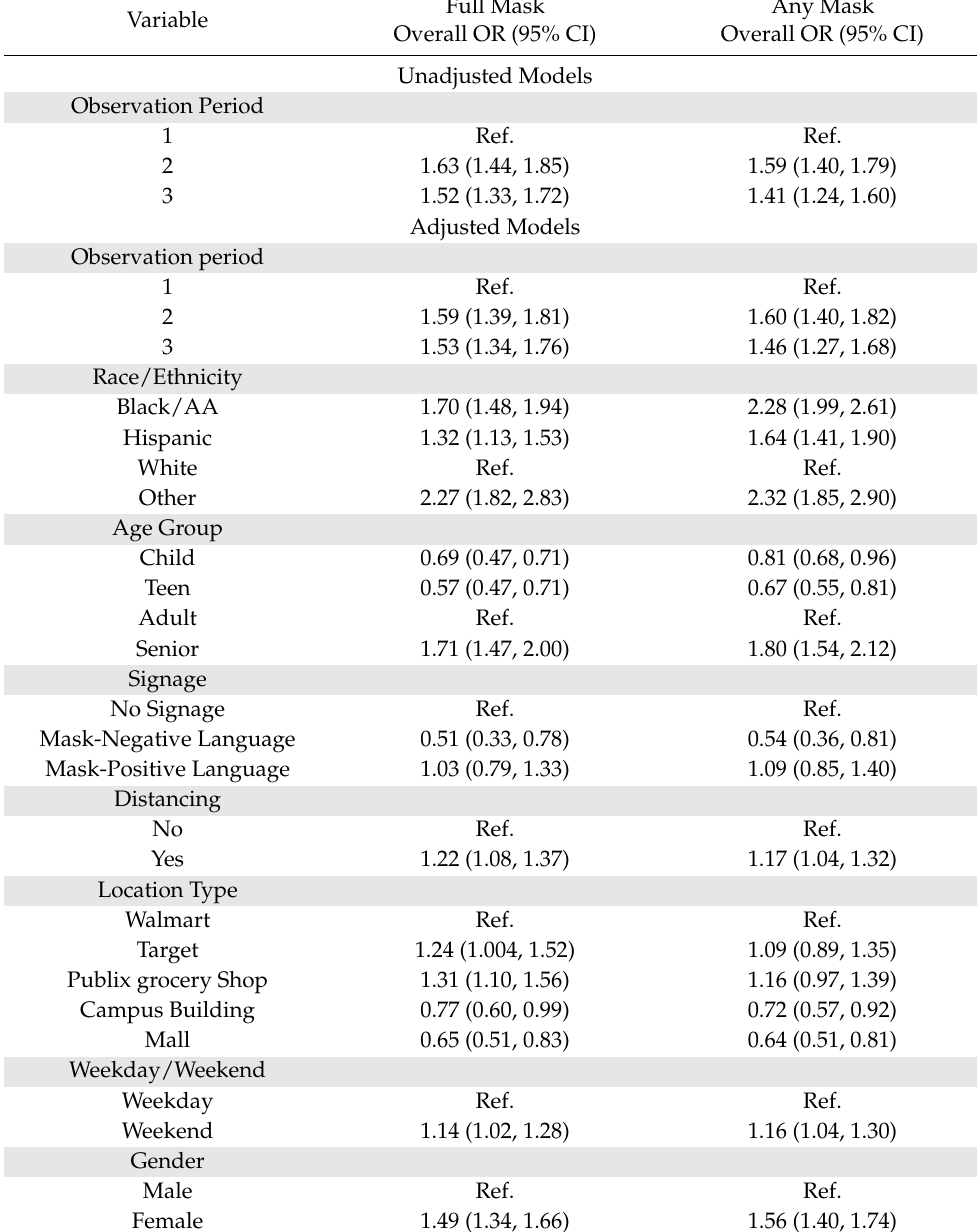
Table 2. Masking by observation period—full mask and any mask (unadjusted and adjusted).